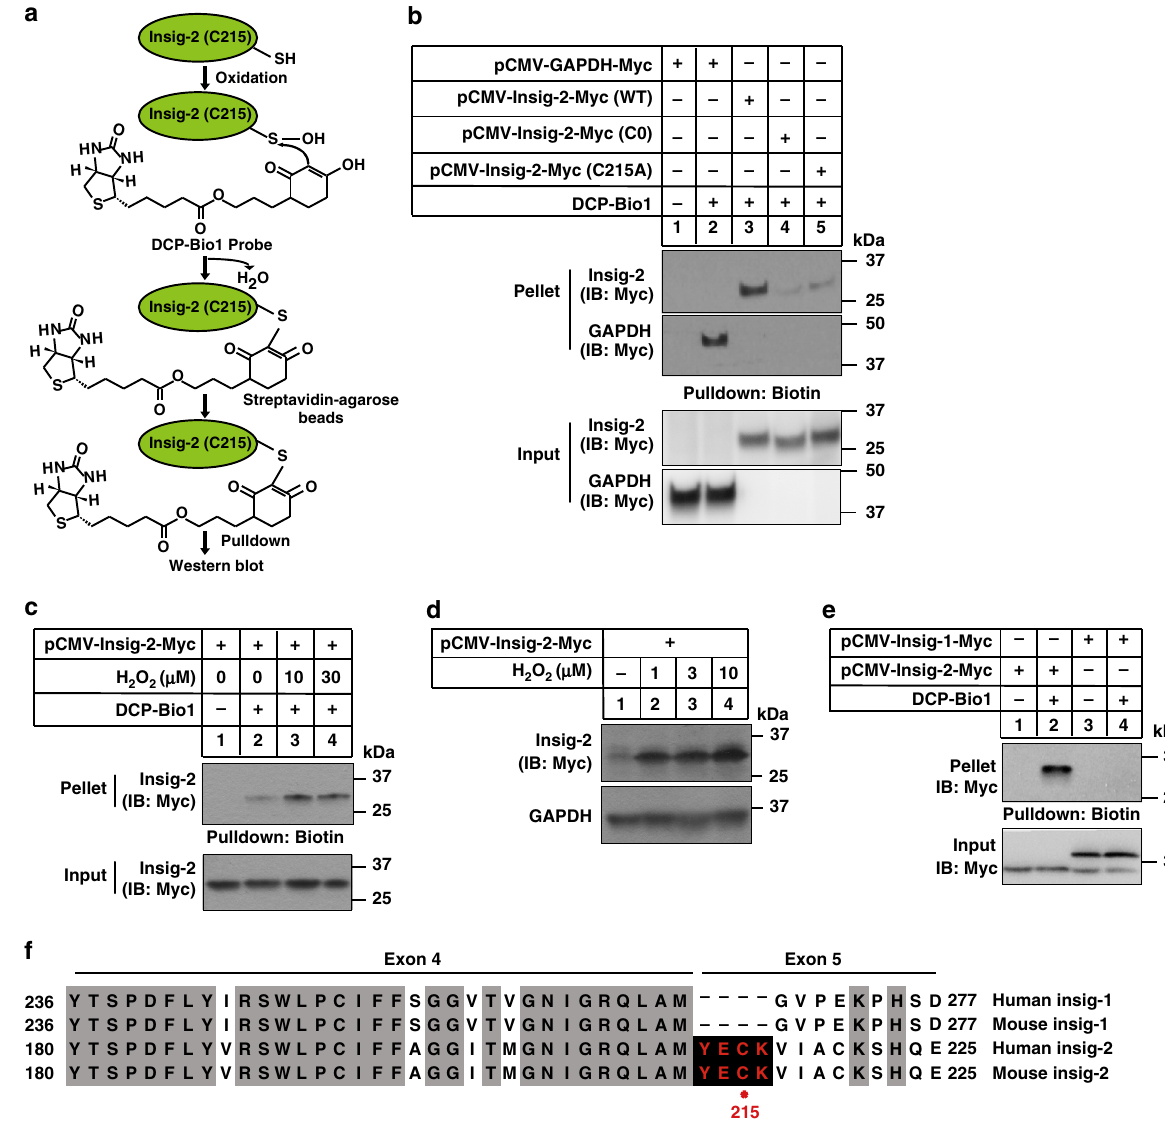
Fig. 4 Cys215 of Insig-2 can be oxidized by ROS. a Procedure of detecting Cys215 oxidation in Insig-2 using the DCP-Bio1 probe. b The CRL1601 cells were transfected with indicated plasmids and harvested for cysteine sulfenic acid detection as described in the Materials and methods. c C2C12 cells were transfected with a plasmid expressing Insig-2 and then treated with H 2 O 2 at indicated concentrations for 10 min. The cells were then harvested for cysteine sulfenic acid detection. d C2C12 cells were transfected with a plasmid expressing Insig-2 and then treated without ( − ) or with 10 μ M H 2 O 2 for 5 h. Cells were harvested for immunoblotting analysis. e CRL1601 cells were transfected with plasmids expressing Insig-1 or Insig-2 as indicated and then harvested for cysteine sulfenic acid detection. f Sequence alignment of human and mouse Insig-1 and Insig-2 proteins. Conserved sequences are highlighted in shadow. The YECK tetrapeptide (in red) is exclusively found in Insig-2 but not Insig-1 proteins. Red dot denotes the ubiquitylation time (Fig. 5d), supporting the notion that differentiation elevates Insig-2 oxidation and thus prevents its ubiquitylation and degradation. Ablation of Insig-2 signi fi cantly elevated the mRNA abundance of Acs , Srebp-1c , Fas , Scd-1 , and glucokinase on differentiation day 6 (Fig. 5e), suggestive of enhanced lipid biosynthesis. The expression levels of Adiponectin were similar in WT and Insig-2 KO cells, indicating that Insig-2 de fi ciency does not interefere adipocyte differentiation (Supplementary Fig. 2d). Consistently, differentiated WT and Insig-2 KO cells exhibited much more Oil Red O staining compared with undifferentiated counterparts, and ablation of Insig-2 exacerbated the phenotype (Fig. 5f, g). In addition, we isolated satellite cells from WT and Insig-2 KO mice. The cells were induced to muscle cells with 2% HS for 2 days. The Insig-2-de fi cient primary muscle cells